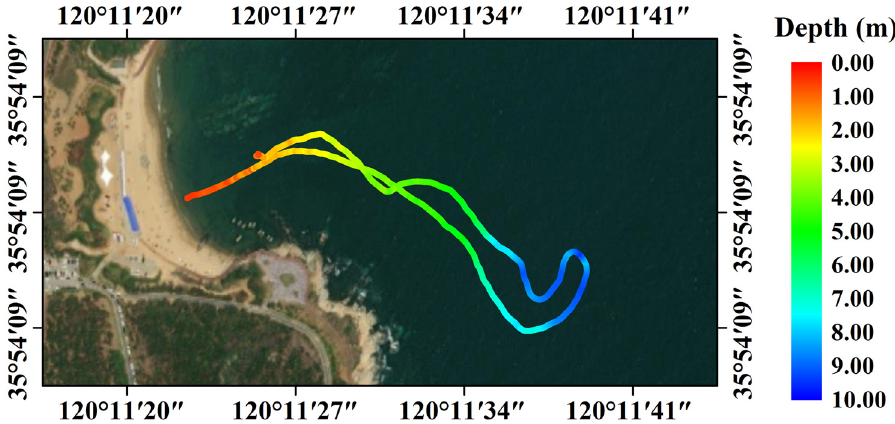
Figure 13. Distribution trajectory and bathymetric results at the Qingdao test field. Table 5. Bathymetric capability and efficiency assessment of SBLS-1 at two test fields. Test